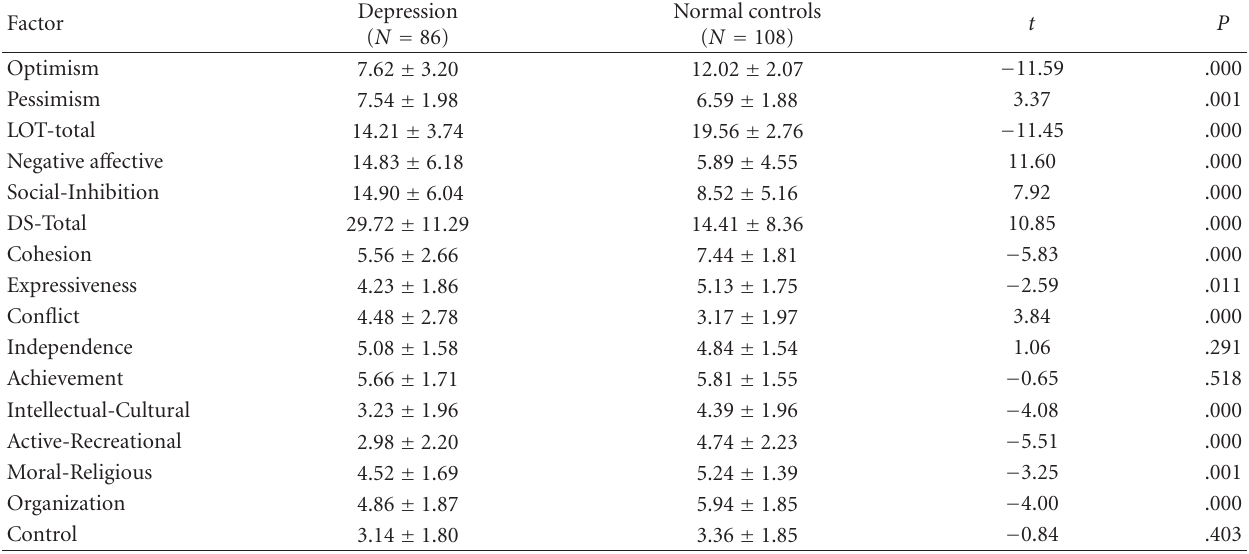
Table 2: Comparison of LOT, DS, and FES between two groups ( x ± s ).